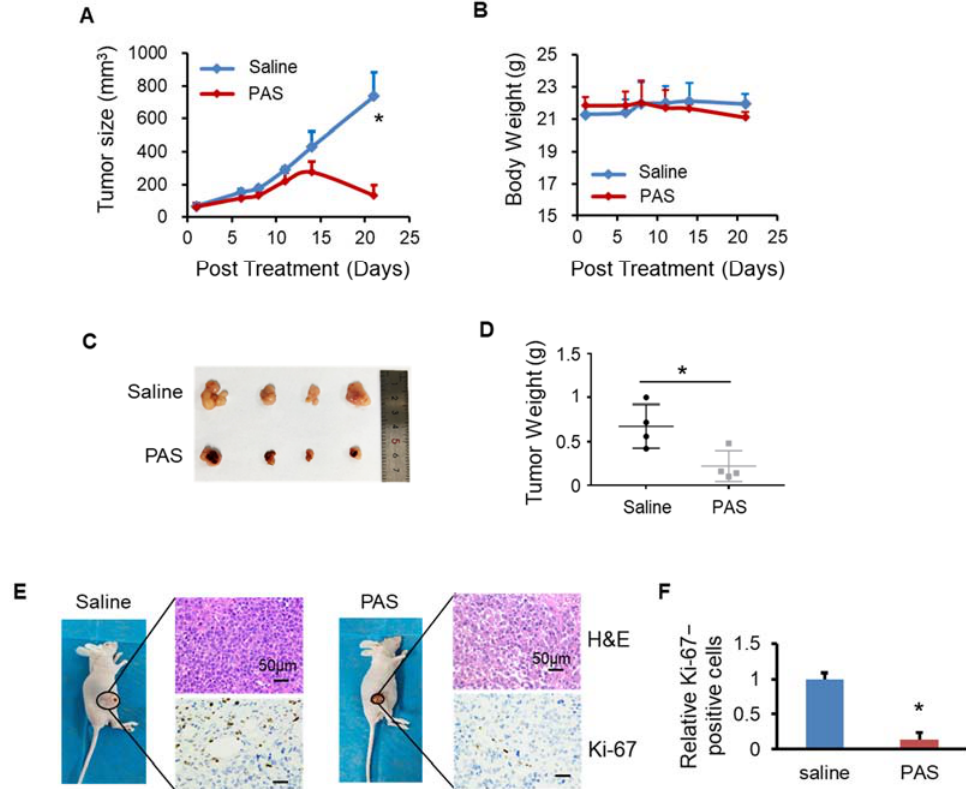
Figure 6. PAS injection significantly suppressed Tca-8113 xenograft tumor growth in vivo. Nude mice bearing Tca-8113 xenografts were grouped and treated with saline or PAS. The tumor size ( A ) and body weight ( B ) were measured. At the end of the experiment, tumors were harvested and weighed ( C , D ). Tumor sections were stained with H&E (upper panel) and Ki-67 (lower panel) ( E ). ( F ) Quantitative analyses of Ki67-positive cells were performed with ImageJ. Data represent the mean ± SD; n = 4; * p < 0.05; scale bar = 50 µ